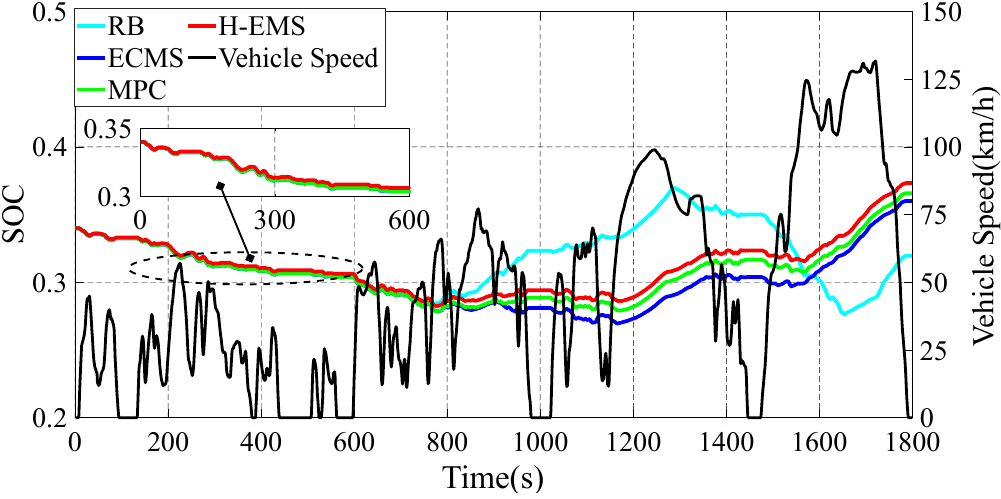
Figure 8. Variation curves of vehicle speed and SOC under different strategies.